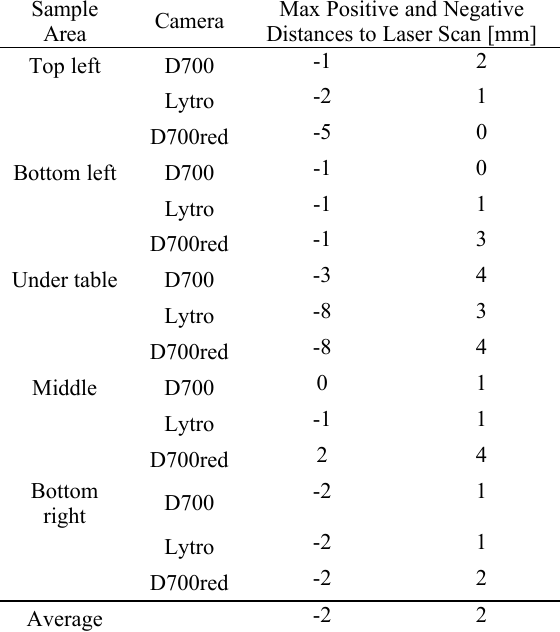
Table 3. Flat sample areas with positive and negative distance to laser scan model.